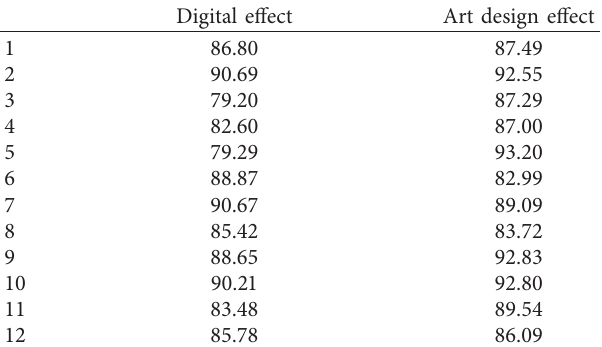
Table 1: System performance test results.